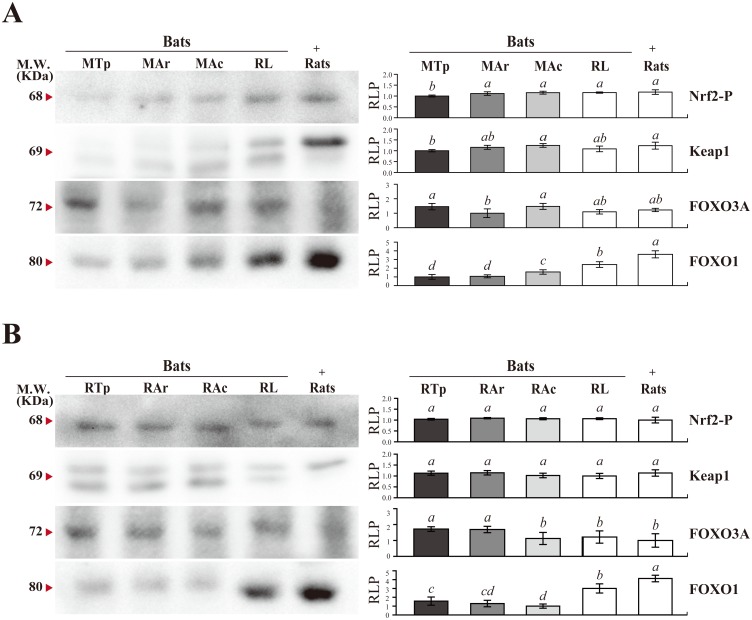
Expression pattern of Nrf2-P, Keap1, FOXO3A, and FOXO1 in bat brain.The amounts of Nrf2-P, Keap1, FOXO3A, and FOXO1 in the brains of the following were determined by Western blotting: non-hibernating R. leschenaultia bats (RL), rats, (A)
M. ricketti bats at torpor (MTp), arousal (MAr), and active states (MAc), and (B)
R. ferrumequinum bats at torpor (RTp), arousal (RAr), and active states (RAc). The bands of rats are used as a positive control (+) for antibody reactions. Arrowheads indicate the predicted molecular weight (KDa) of a protein. Relative levels of protein expressions (RLP) are represented by bar plots. The lowest level of a detectable protein is set as 1. Values of group means are represented by italicized letters and are in the order of a > b > ab > c > cd > d. The difference in value is significant (P < 0.05) between different letters.